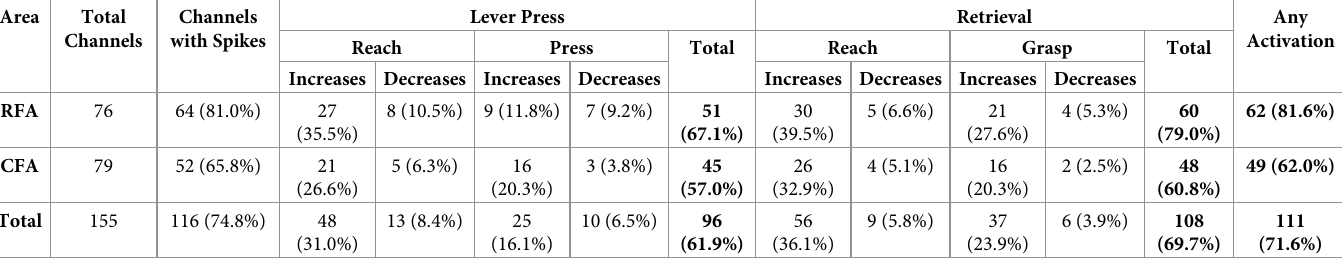
Lever Press Retrieval Any